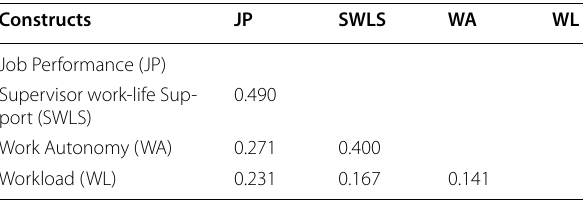
Table 3 HTMT (Heterotrait-Monotrait ratio)